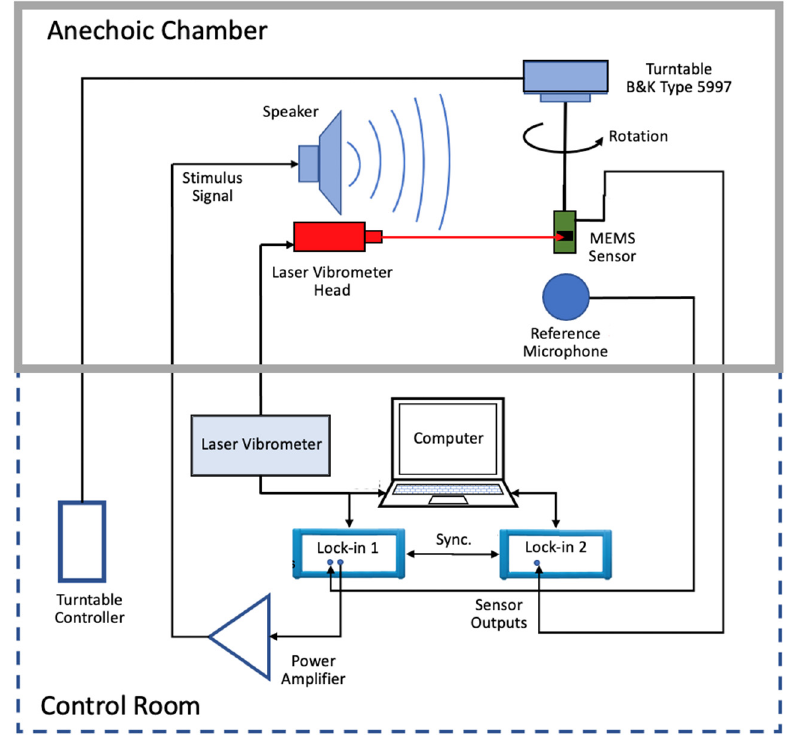
Figure 7. Schematic diagram of the experimental setups used to perform measurements of mechanical sensitivity, electric sensitivity, and noise. Details in the text.